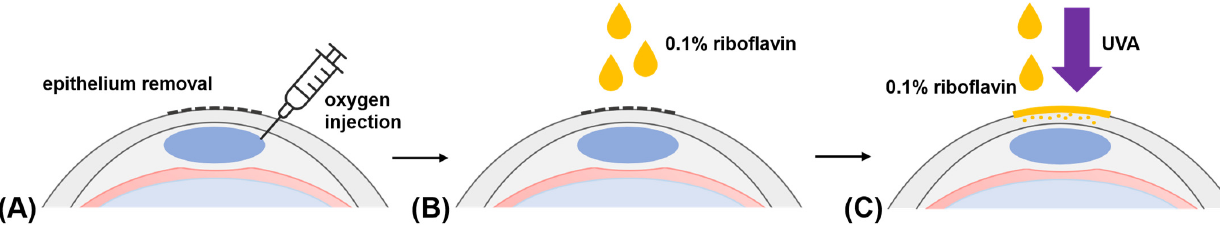
Figure 1. Bubble-CXL: ( A ) The epithelium is removed, and intracameral oxygen is injected into the eye. ( B ) A 0.1% riboflavin solution is instilled on the eye every 5 min for 30 min, ( C ) followed